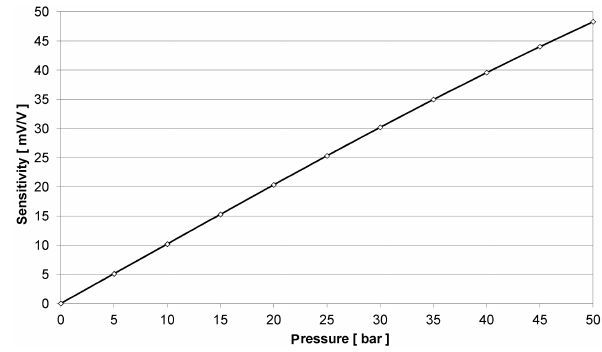
Figure 9. Sensitivity, nominal pressure range is